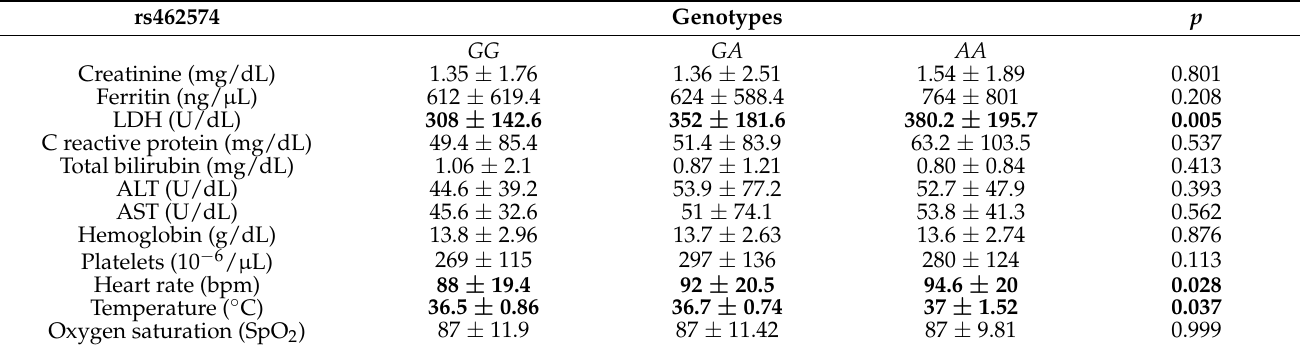
Table 4. Distribution of the damage biochemical markers in the COVID-19 patients according to the